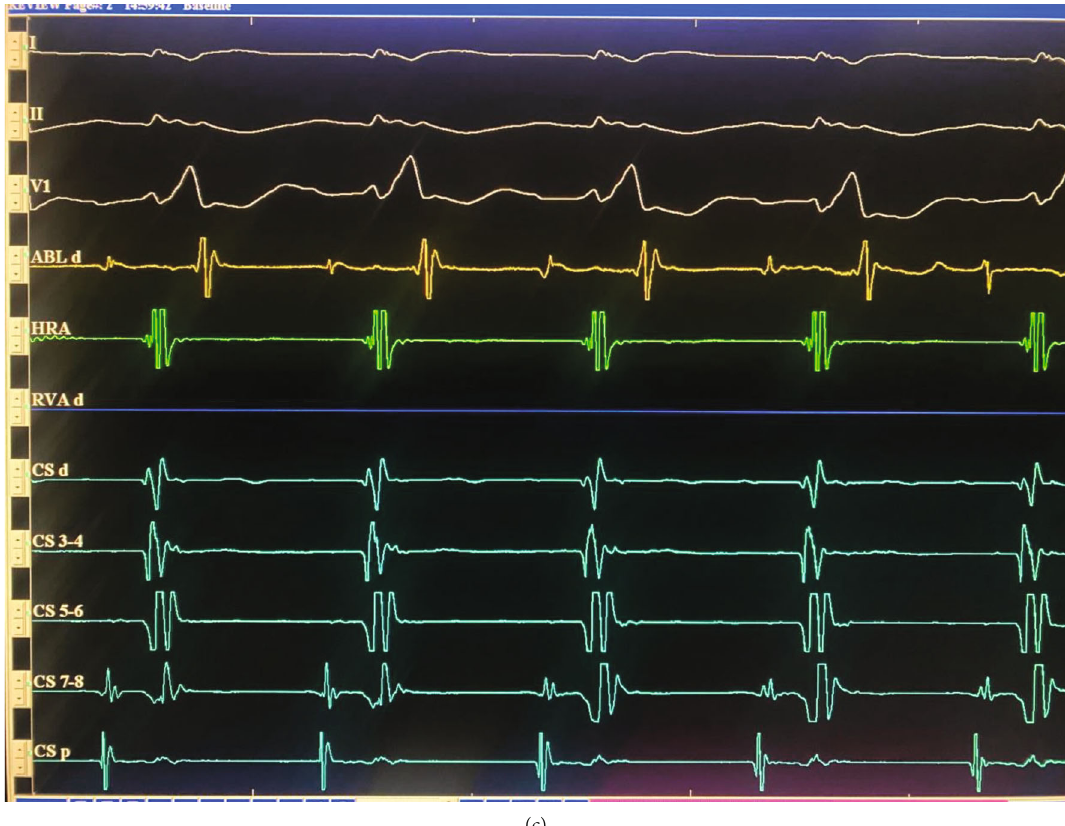
Figure 3: (a) AP potential in EGM in the right lateral of the right atrium. (b) We used the long sheath SL1 to stabilize the ablation catheter to the ablation site and improve the contacting of ablation catheter and myocardium (RAO and LAO views, white star shows target point to ablation). (c) AP potential disappears after ablating the target